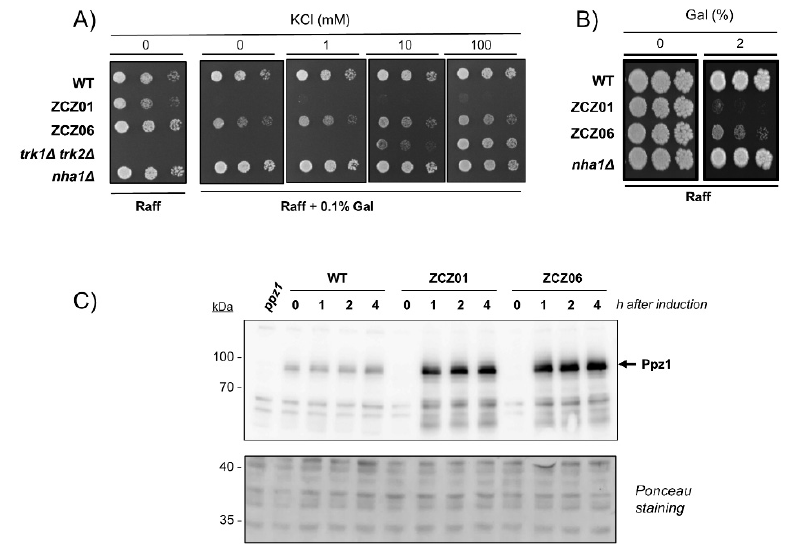
Figure 1. Deletion of NHA1 counteracts Ppz1 overexpression toxicity. ( A ) Growth of strains BY4741 (WT), ZCZ01 ( GAL1 : PPZ1 ), ZCZ06 ( GAL1 : PPZ1 , nha1 ∆ ), DSC32 ( trk1 ∆ trk2 ∆ ), and CCP011 ( nha1 ∆ ) under the conditions of Ppz1 overexpression and in the presence of KCl. Cells were spotted on translucent medium with 2% raffinose and 0.1% galactose (where indicated) and supplemented with different concentrations of KCl. Plates were incubated for 6 days at 28 °C. ( B ) Cells were spot- ted as above in YP–Raff medium with or without 2% galactose (Gal). Growth was monitored after 6 days. ( C ) Immunodetection of Ppz1 in strains: BY4741 (WT), ZCZ01 ( GAL1 : PPZ1 ), and ZCZ06 ( GAL1 : PPZ1 nha1 ∆ ). Extracts from cells transferred to galactose-containing medium were prepared as described in Material and Methods, subjected to SDS–PAGE (10% gels), and transferred to mem- branes. Ppz1 was detected with a polyclonal antibody. Membranes were subjected to Ponceau red staining to monitor loading and transfer efficiency.